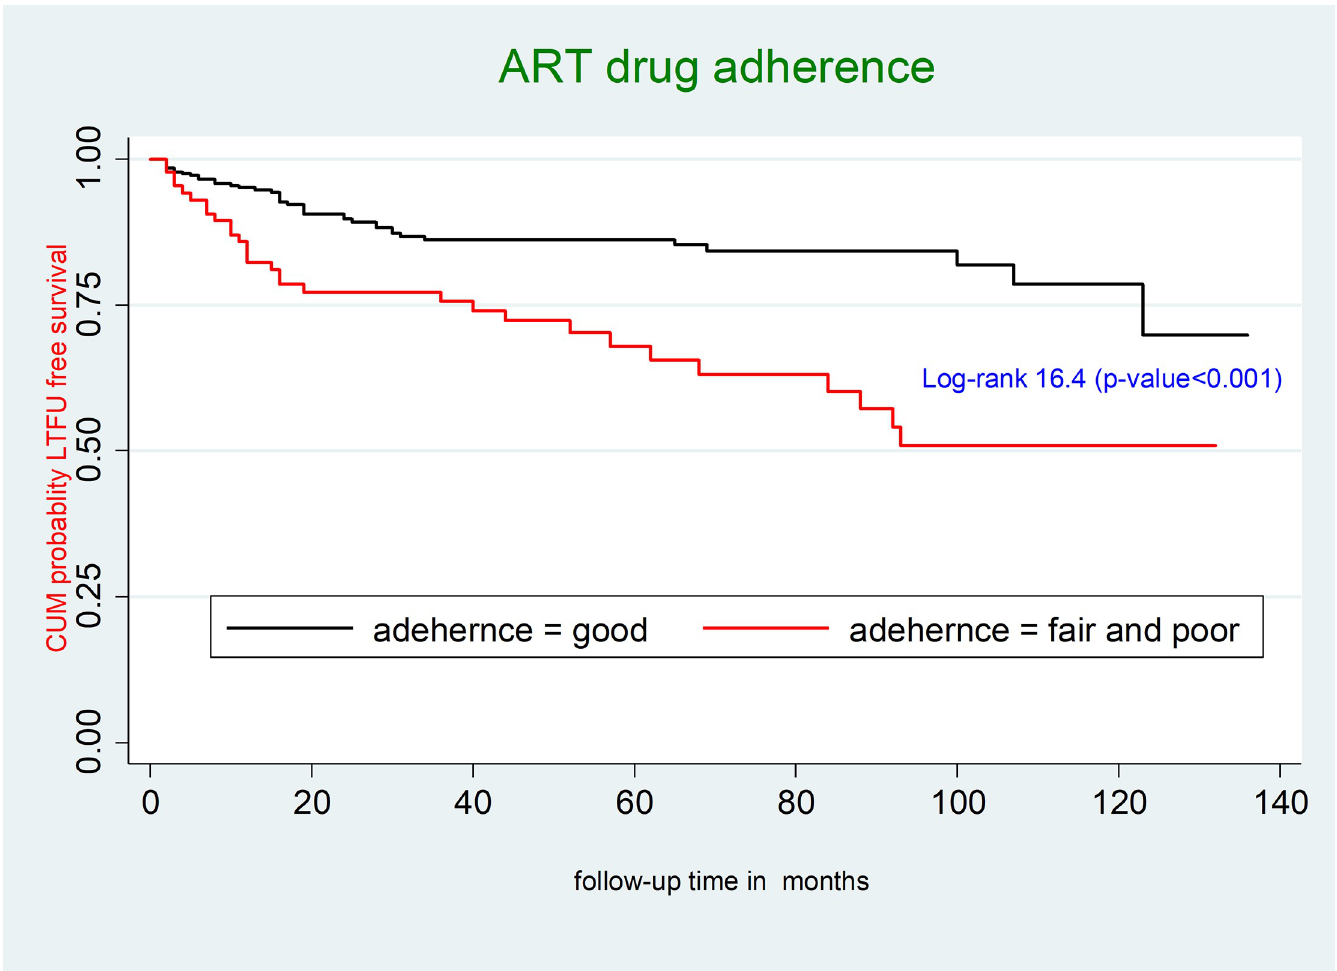
Fig 3. Kaplan-Meier survival curves to compare LTFU among HIV-infected children receiving ART between good and fair or poor ART drug adherence at Debre-Markos Referral Hospital, Northwest Ethiopia, 2019.